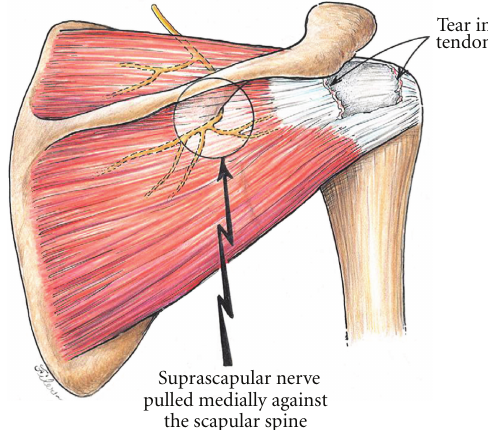
Figure 2: Medial traction on the suprascapular nerve secondary to a massive rotator cu ff tear involving the supraspinatus and infraspinatus. From Costouros et al. [7]. Permission